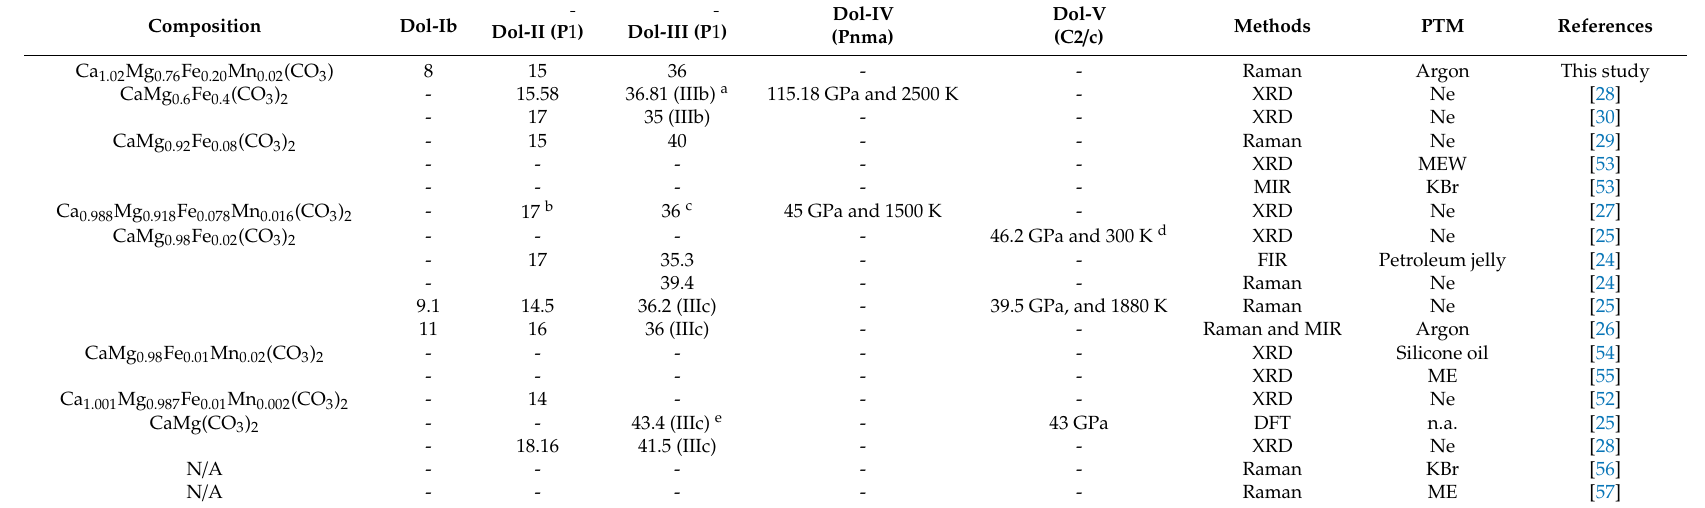
Table 3. Overview of the current literature about dolomite and a comparison of the methods used, composition, and phase transition pressure.